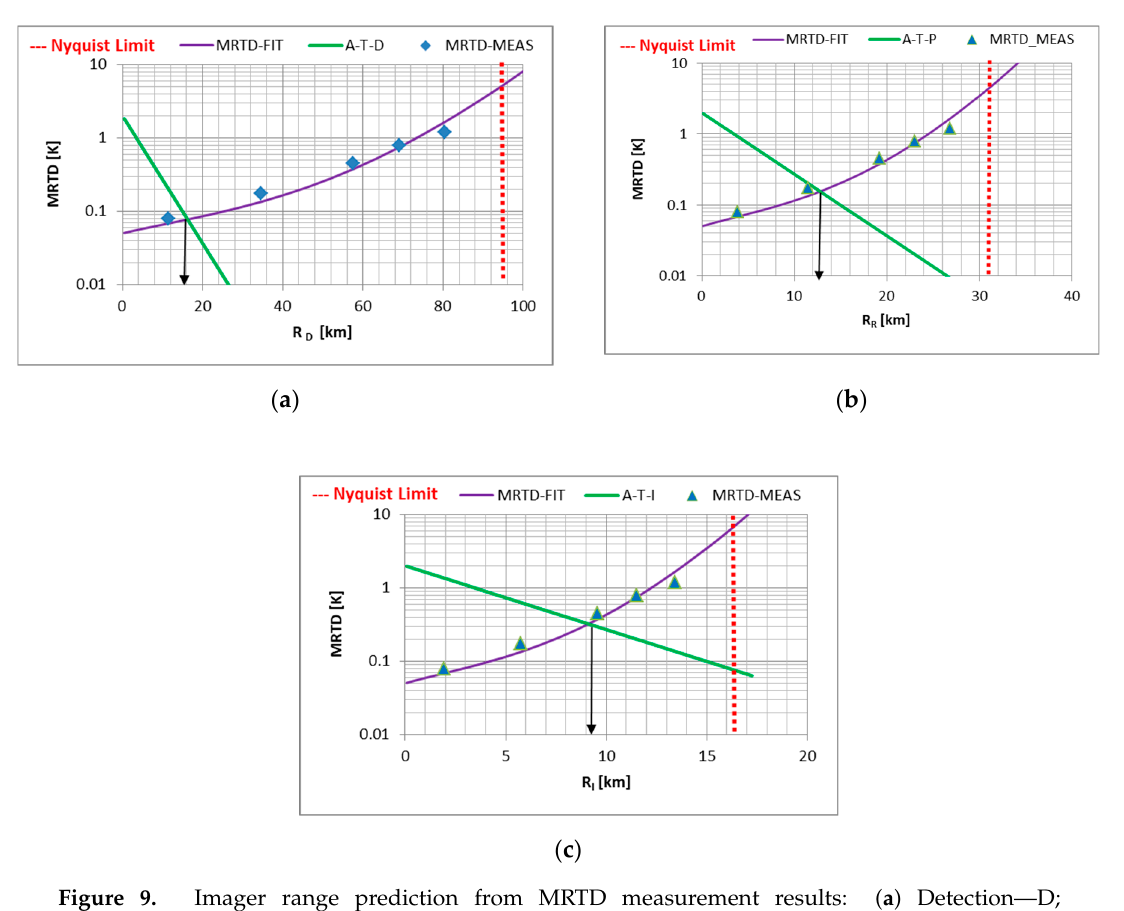
Figure 9. Imager range prediction from MRTD measurement results: ( a ) Detection—D; ( b ) recognition—R; ( c ) identification—I.